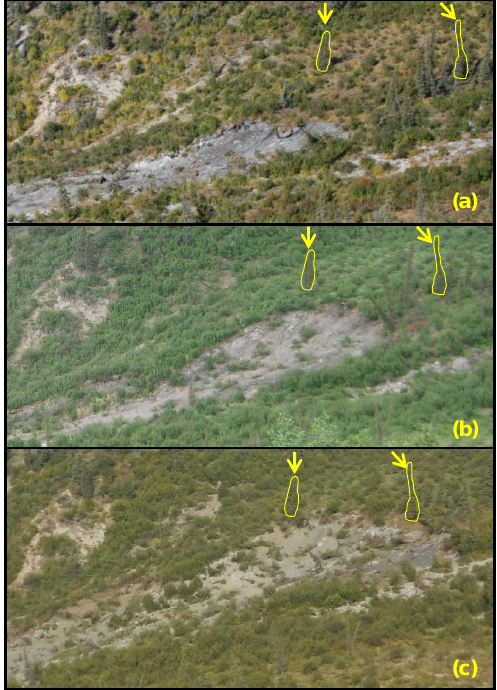
Figure 3. Retrogressive thaw slump (RTS) development on FDL-A: (a) August 2008; (b) June 2013; (c) August 2015. Arrows and out- lines indicate the same two trees in all three images for